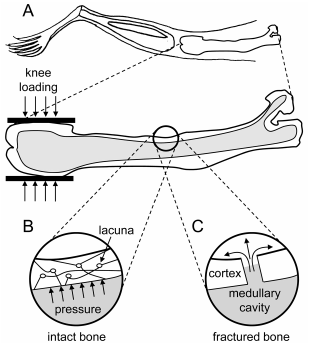
Figure 2. ( A ) schematics of mouse femur under loading; ( B ) pressure increase in the bone cortex; and ( C ) fluid flow in a fractured bone cortex.